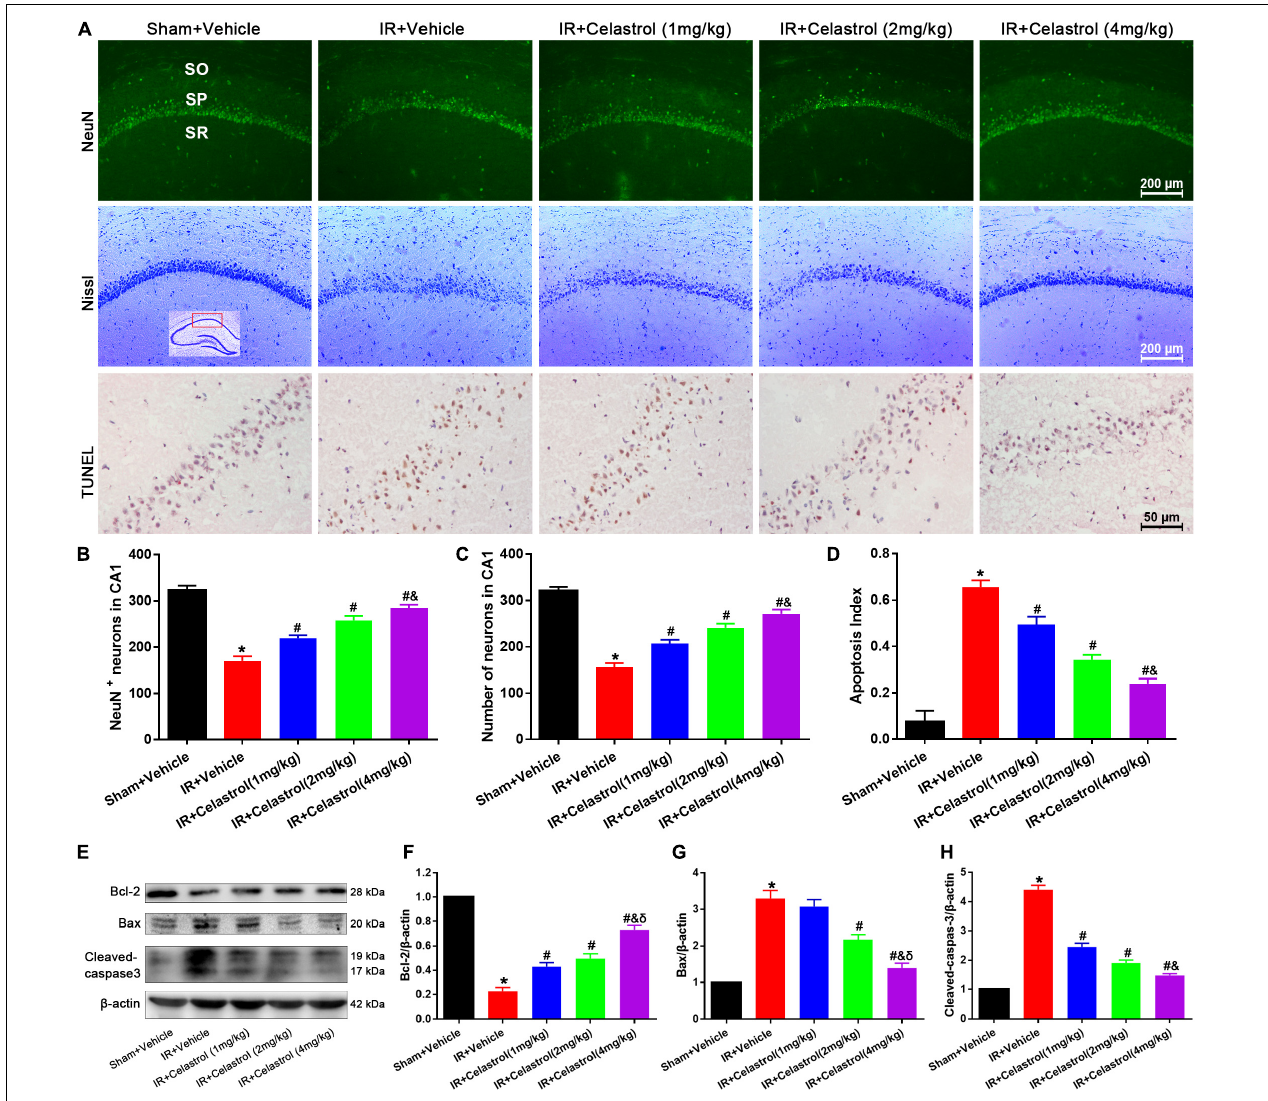
FIGURE 2 | Celastrol inhibits apoptotic hippocampal neuronal death. (A) Representative images of NeuN immunofluorescent staining sections (first row), cresyl violet-stained sections (second row) and TUNEL-stained sections (third row) in hippocampal CA1 region of tGCI/R rats, the built-in schematic diagram with red rectangular shows the area that we analyzed. Data were obtained from 4 independent animals, and the results of a typical experiment are exhibited. Scale bar = 200 µ m. SO, stratum orients; SP, stratum pyramidal; SR, stratum radium. (B) Quantitative analysis of NeuN positive neurons. (C) Quantitative analysis of Nissl-positive neurons (D) The apoptosis index of hippocampal CA1 neurons. (E–H) Western blot analysis of apoptosis-related proteins Bcl-2, Bax and cleaved-caspase-3, β -actin was used as an internal control. The error bars represent mean ± S.E.M ( n = 4, ∗ P < 0.05 vs. Sham + Vehicle group; # P < 0.05 vs. IR+ Vehicle group; & P < 0.05 vs. IR + Celastrol (1 mg/kg) group; δ P < 0.05 vs. IR + Celastrol (2 mg/kg)